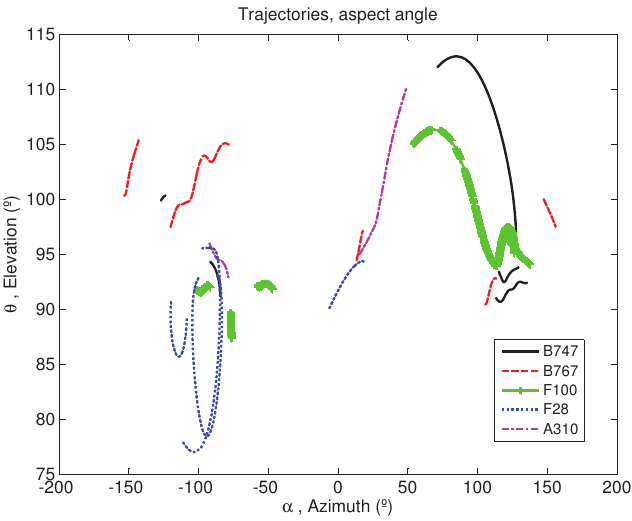
Figure 4. Aspect angles of the measured HRRP.